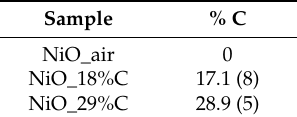
Table 1. Percentage of carbon in each sample.